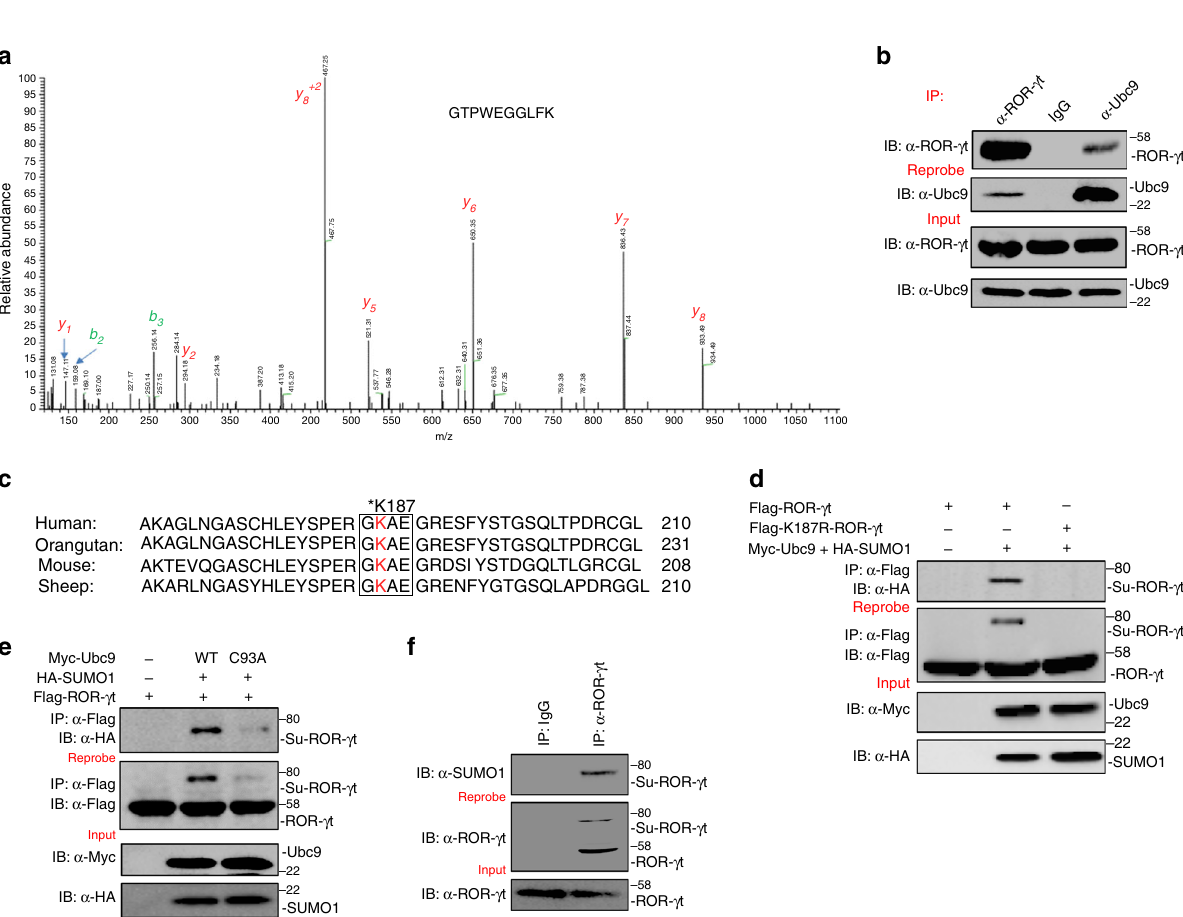
Fig. 1 Ubc9 interacts with and SUMOylates ROR- γ t. a Lysate was prepared from cLPLs of WT mice and subjected to immunoprecipitation with anti – ROR- γ t antibody or control IgG antibody. The precipitated proteins were subjected to SDS-PAGE and in-gel digestion. The resulting peptides were analyzed by high-resolution MS/MS. Ubc9 (SwissProt #P63280) was identi fi ed as a speci fi c interactor of ROR- γ t protein. An MS/MS spectrum of the peptide 50 GTPWEGGLFK 59 ([M + H] + 2 = 546.27 m/z ) belonging to Ubc9 is shown. Observed b - and y- ions are indicated. b Lysates from cLPLs of WT mice were immunoprecipitated with anti-ROR- γ t, anti-Ubc9 antibody, or control IgG antibody, and immunoblot analysis with antibody against ROR- γ t or Ubc9 was performed. c Sequence alignment was conducted for ROR- γ t. The box indicates the conserved SUMOylation ( Ψ -K-X-D/E) motif. d Total cell lysates from 293 T cells transfected with Myc-Ubc9, HA-SUMO1, and either Flag-ROR- γ t or Flag-K187R-ROR- γ t were immunoprecipitated with anti-Flag antibody. The immunoprecipitates were analyzed by immunoblot assay with anti-HA antibody to detect the SUMOylated form of ROR- γ t. e Total cell lysates from 293 T cells transfected with Flag-ROR- γ t, HA-SUMO1, and either Myc-Ubc9 or Myc-Ubc9-C93A were immunoprecipitated with anti-Flag antibody and immunoblotted with anti-HA antibody to detect the SUMOylated form of ROR- γ t. f Lysates were prepared from cLPLs of WT mice and immunoprecipitated with anti – ROR- γ t antibody or control IgG antibody. The immunoprecipitates were immunoblotted with anti-SUMO1 antibody. The data are